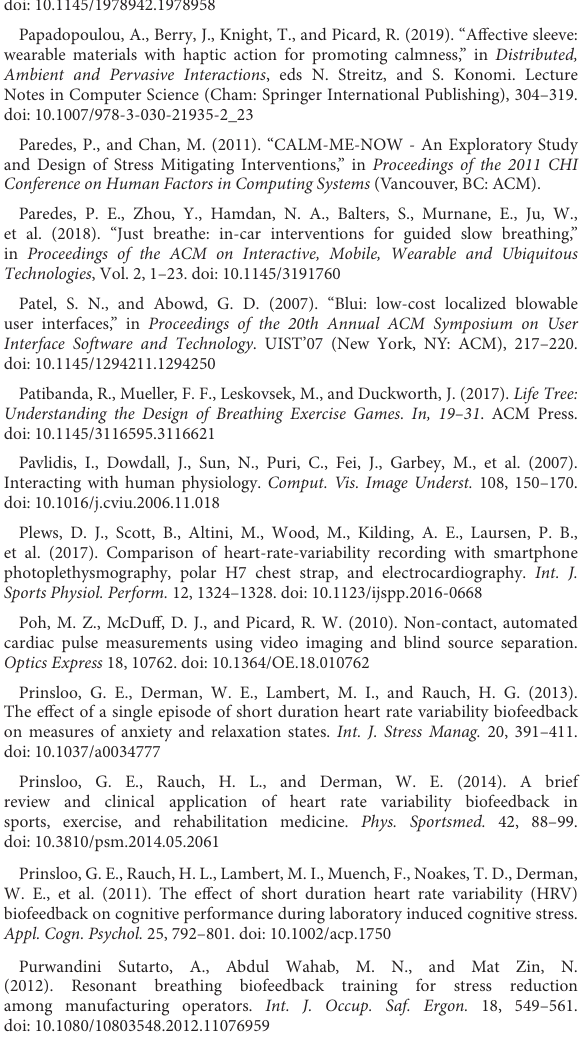
Tabor, A., Bateman, S., and Scheme, E. (2019). Breathing Physiology and Guided BreathingExercise:APrimer.TechnicalReport .UniversityofNewBrunswick,New Brunswick. Available online at: https://www.cs.unb.ca/tech-reports/documents/ TR19-241.pdf (accessed November 15, 2022). Tabor, A., Bateman, S., Scheme, E., and Sadprasid, B., schraefel M. (2021). “Understanding the design and effectiveness of peripheral breathing